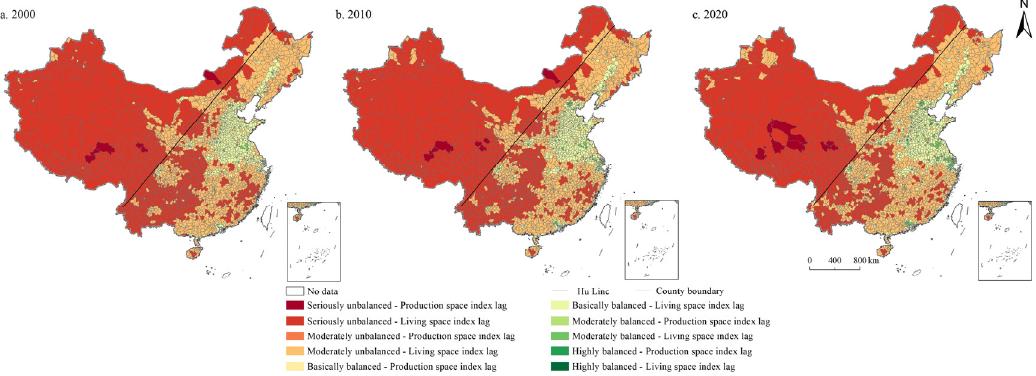
Figure 9. Spatial distribution of coordination degree of PLES index subcategory in China during